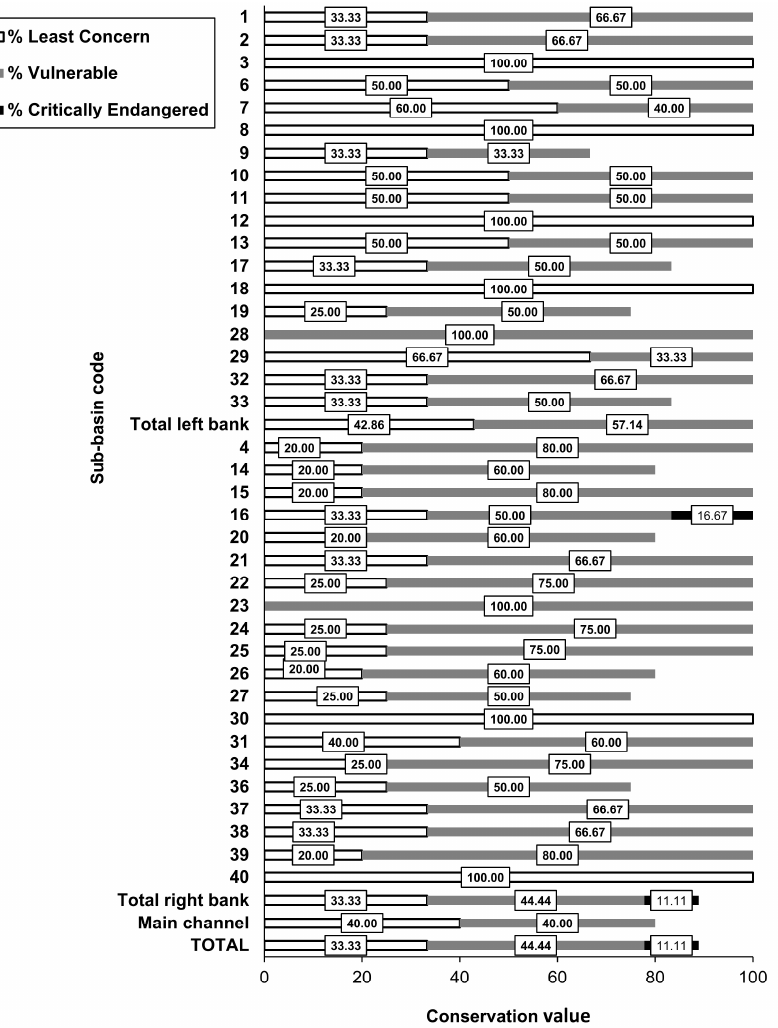
Figure 4. Conservation status (%) of sampled threatened fish species (IUCN red list criteria, version 15.1. July 2022) in different Guadalquivir River sub-basins.